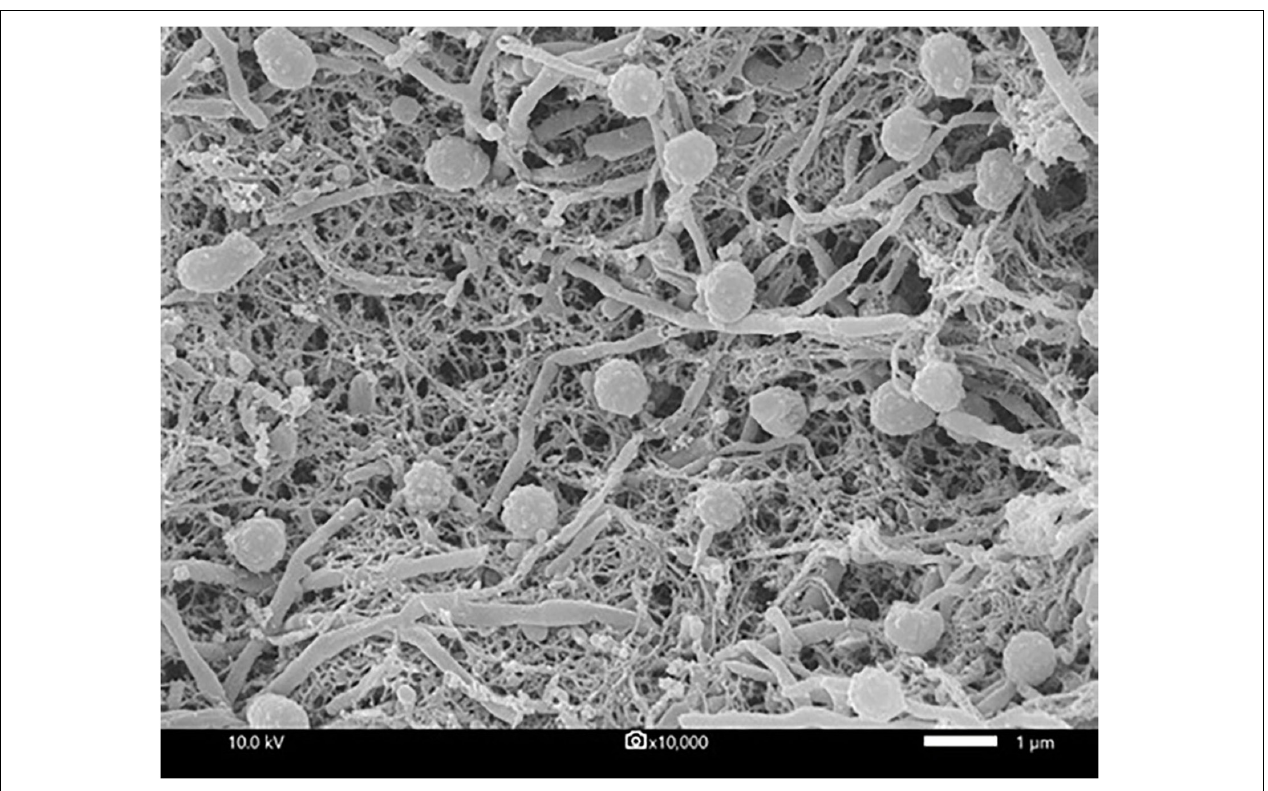
FIGURE 5 | Scanning electron micrograph showing M. chalcea CMU55-4 grown on ISP2 agar medium at 30 ◦ C for 21 days. Bar represents 1 µ